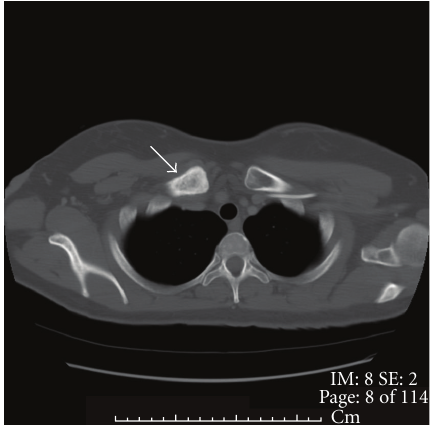
Figure 1: 46-year-old woman with pancreatic cancer and prior distal pancreatectomy. CT scan with contrast through the pancreas. There is calcification at the cut surface of the pancreas (white arrow). No residual tumor is seen at this site. Cholecystectomy clips are present in the gall bladder fossa (black arrow).